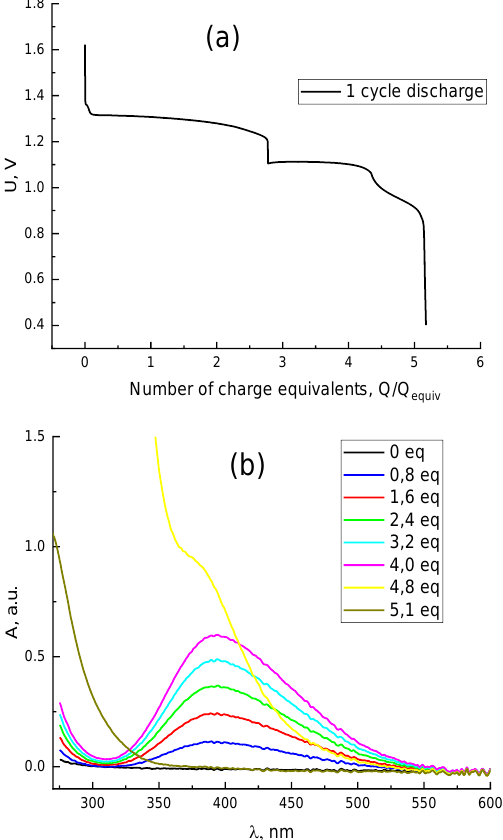
Figure 5. Discharging curve of a H 2 /BrO 3 − flow battery ( a ) and evolution of the corresponding spectrum of the catholyte ( b ) in the course of galvanostatic polarization by − 0.075 A/cm 2 , starting composition of the positive-electrode solution: product of stage (Figure 4a), reactant of the negative electrode: hydrogen, gas flow rate: 10 mL/min.